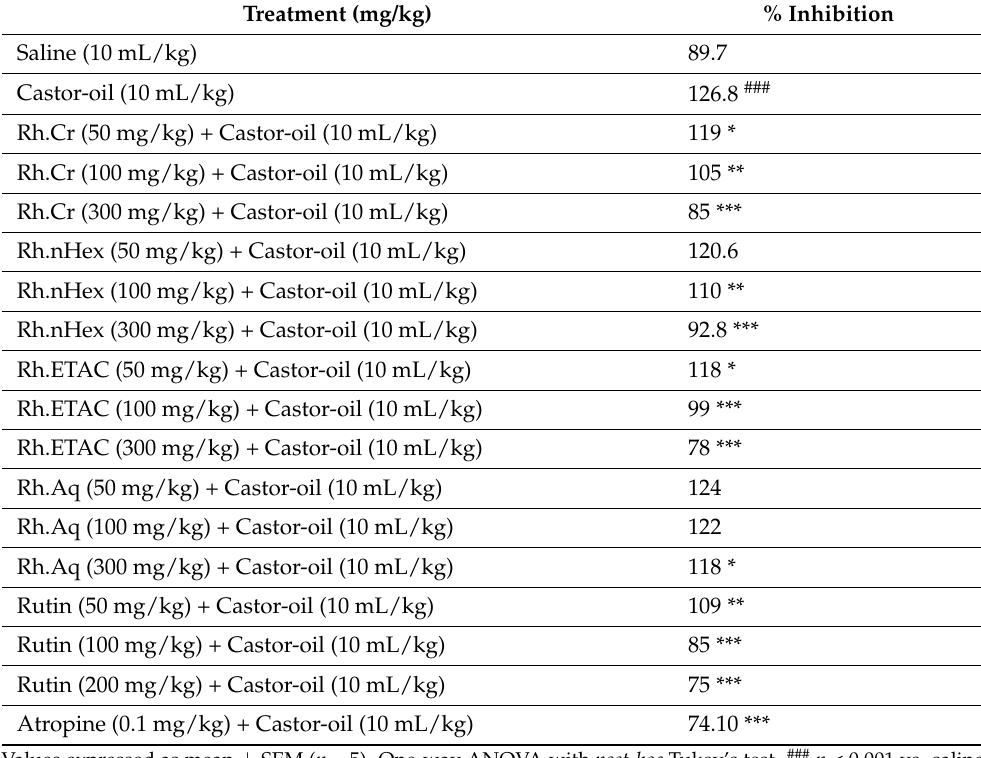
Table 4. Effect of Rumex hastatus crude extract (Rh.Cr) and fractions: n-hexane (Rh.n-Hex), ethyl acetate (Rh.ETAC), aqueous (Rh.Aq), rutin and atropine against castor-oil induced fluid accumulation in mice. Treatment (mg/kg) % Inhibition Saline (10 mL/kg) 89.7 126.8